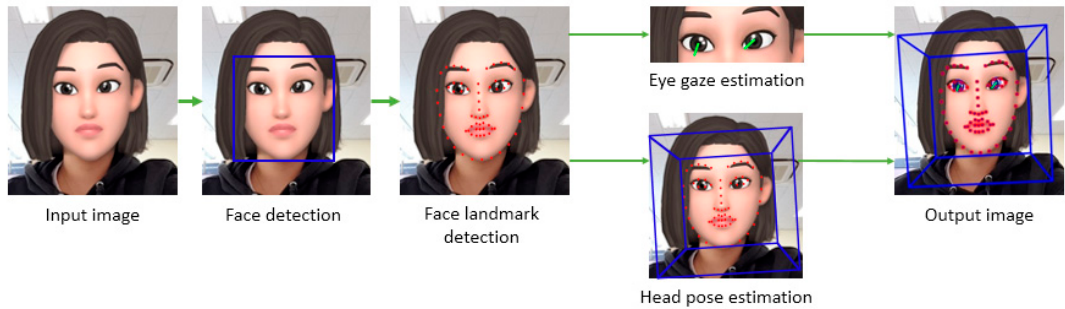
Figure 2. Facial and eye movement extraction by OpenFace 2.0 [23].